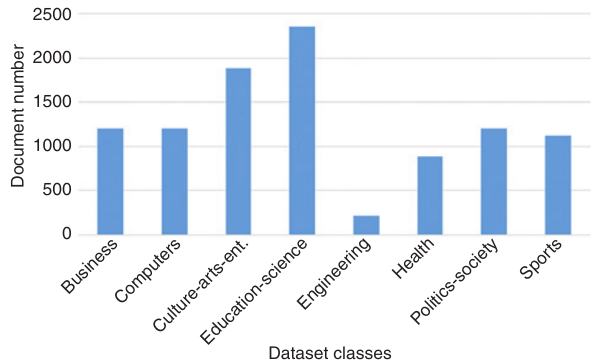
Figure 2: Snippets Data Set Classes.